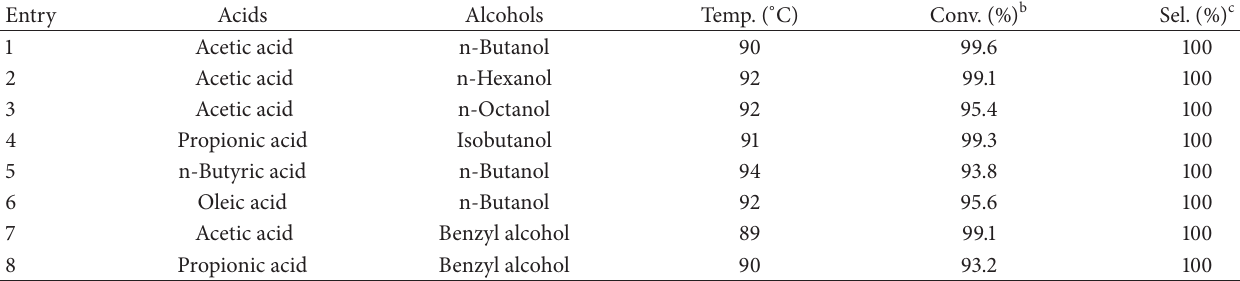
Table 4: Esterification of different alcohols and carboxylic acids in [ PVPP-BS ] HSO 4 a .